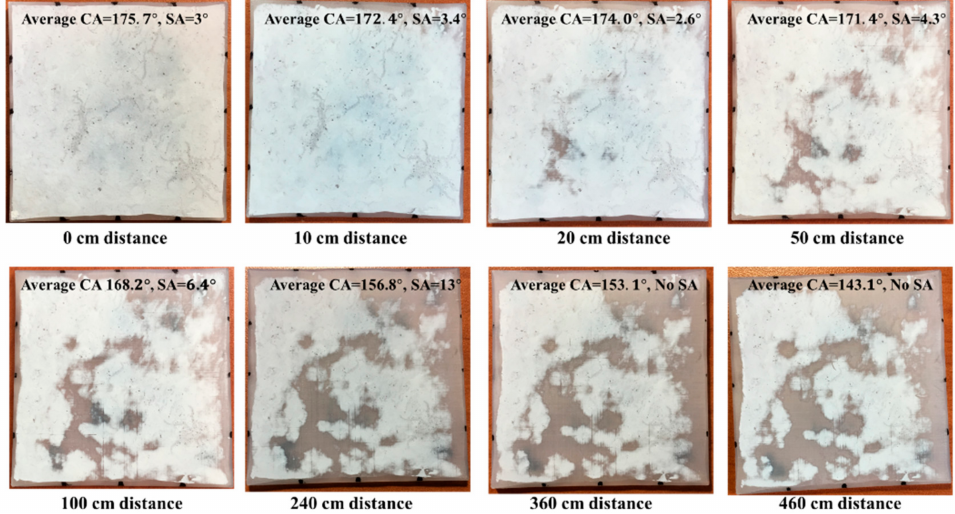
Figure 11. Images of sample surfaces during the scratch test with